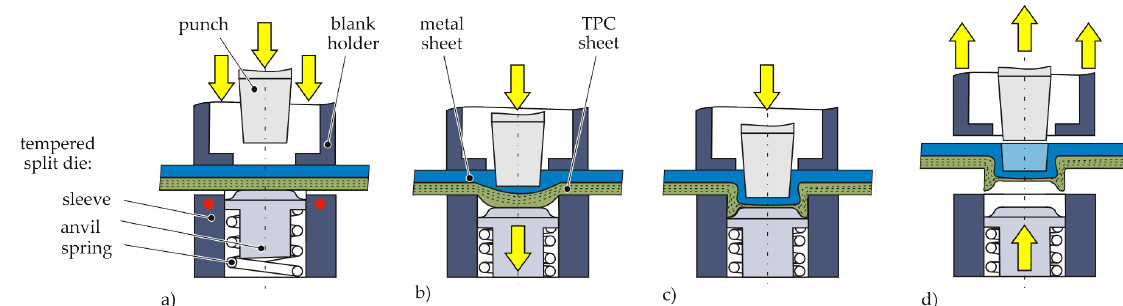
Figure 4. Schematic illustration of the Hotclinching process: ( a ) positioning, heating and fixation, ( b ) offsetting, ( c ) upsetting and flow pressing, ( d ) releasing finished joint.